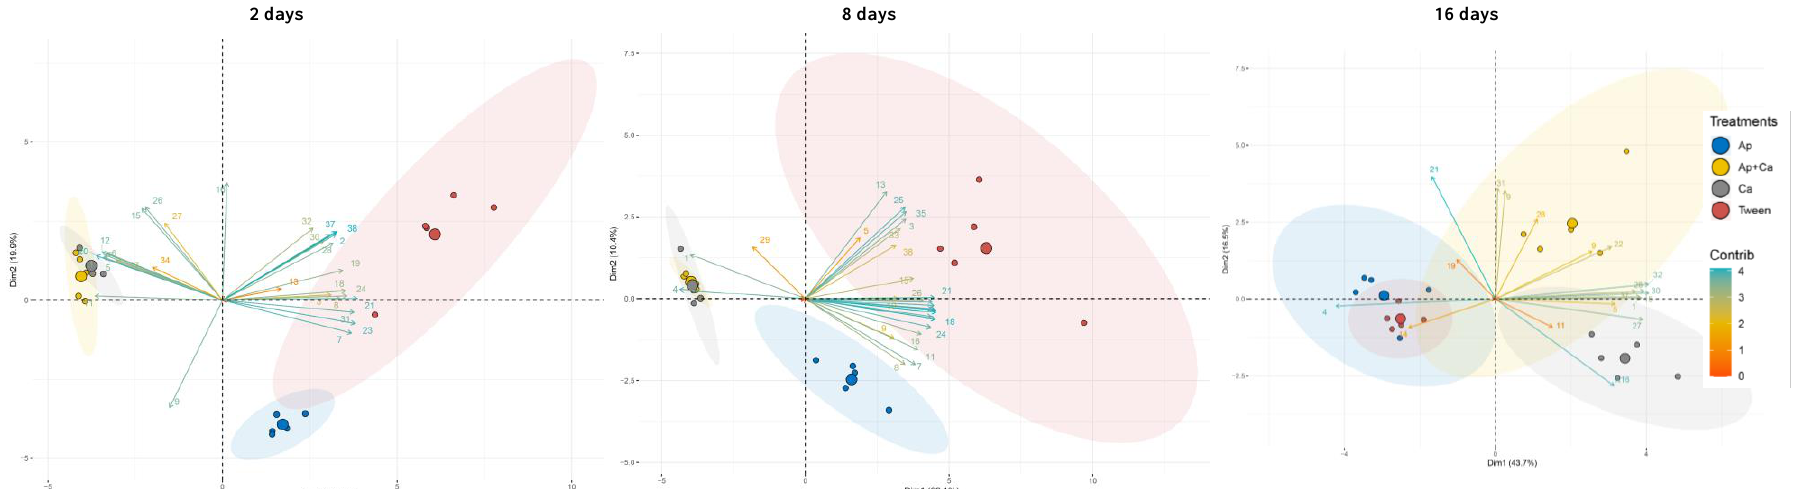
Figure 5. Principal component analysis score plots obtained from the volatile profile of olives inoculated with Aureobasidium pullulans and Colletotrichum acutatum (Ap + Ca), or solely with A. pullulans (Ap), C. acutatum (Ca) or Tween, after 2, 8 and 16 days of pathogen inoculation. Each number corresponds to a particular volatile compound, as indicated in Table 1. The gradient color represents the contribution of each variable (i.e., volatile compounds) to the explanation of the greatest variance in the dataset. Each circle represents treatments, with the ones with the greater size representing the average.